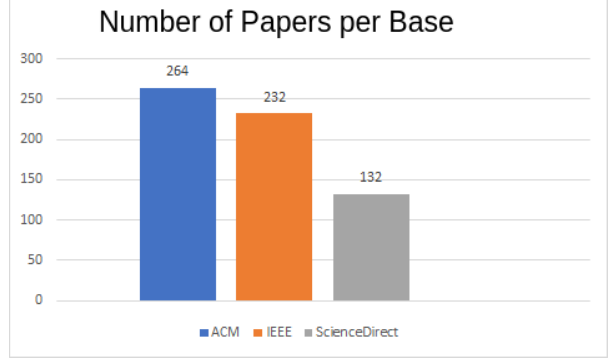
Figure 3. Number of Papers per